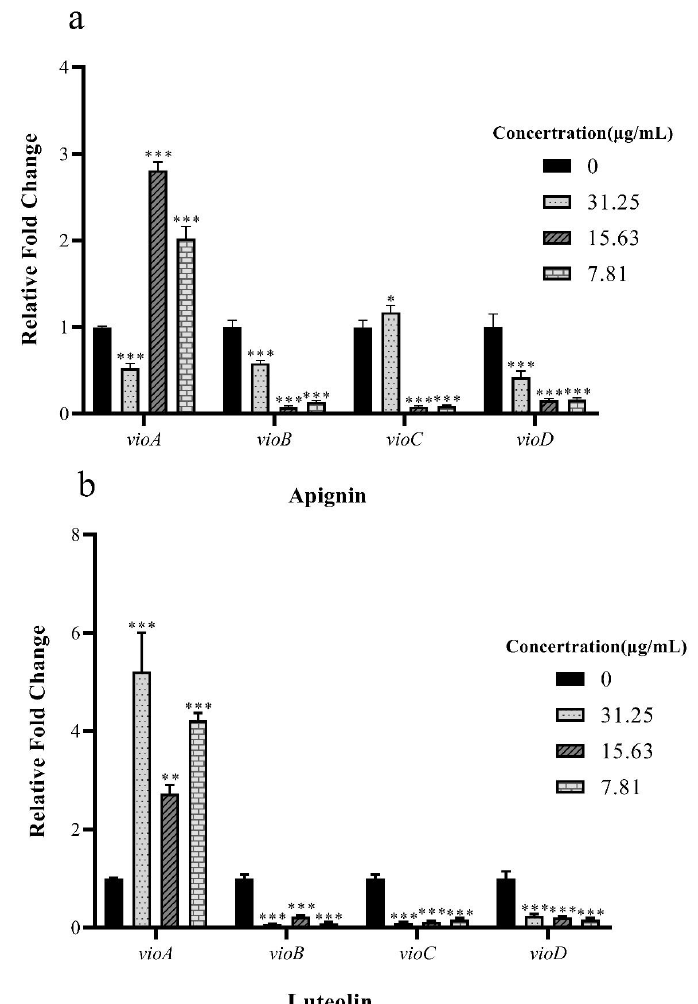
Figure 8. The ability of apigenin and luteolin to inhibit the expression of key genes of C. violaceum quorum sensing ( a ) is the apigenin group, and ( b ) is the luteolin group. We can find that both of them do not inhibit the expression of the vioA gene, and that luteolin has a relatively obvious effect on vioB , vioC , and vioD inhibition, while apigenin is not as good as luteolin in inhibiting the inhibition of the vioC gene. Columns represent means ± standard deviations. Statistically significant differences (determined by Student’s t -test) are indicated as *** p < 0.001, ** p < 0.01, and * p < 0.05 vs. the control